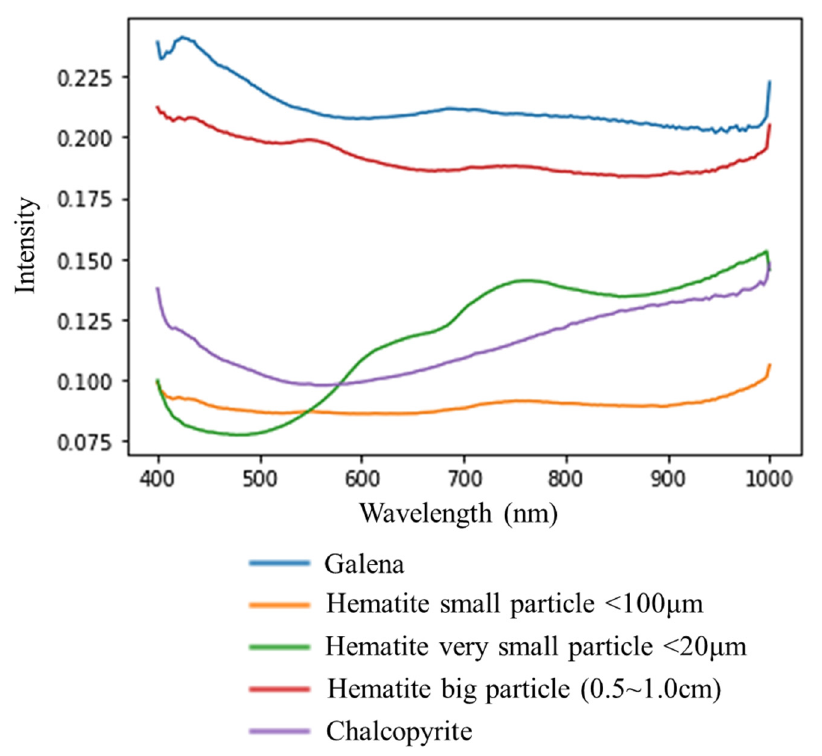
Minerals 2020 , 10 , x FOR PEER REVIEW Figure 8. Averaged obtained hyperspectral data of each mineral. Figure 8. Averaged obtained hyperspectral data of each mineral.